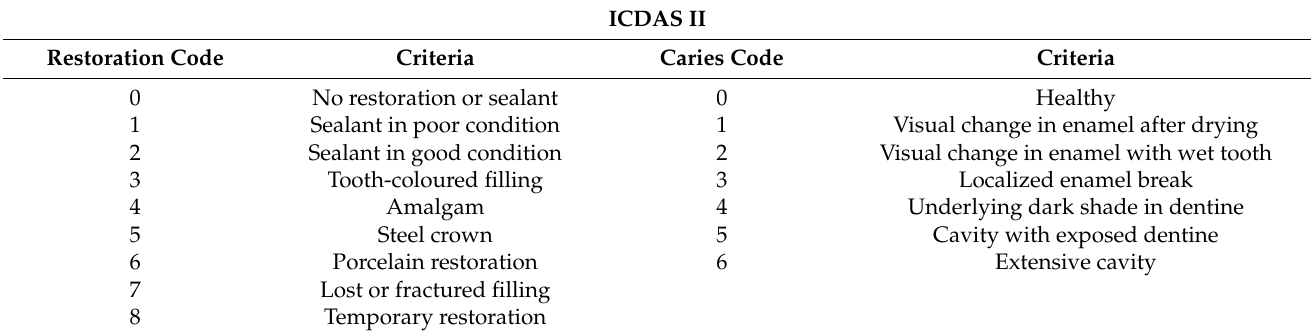
Table 1. ICDAS II (International Caries Detection and Assessment System)